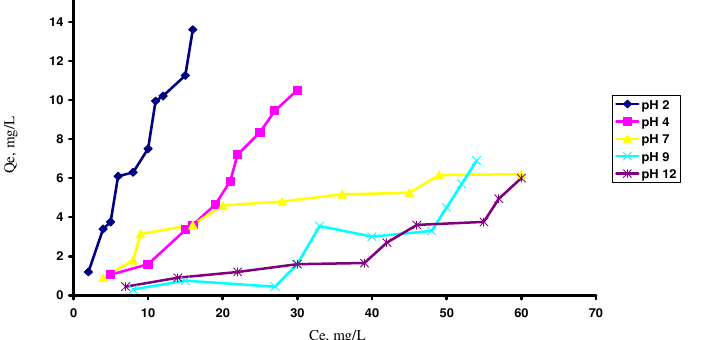
Figure 6. Removal of colour from aqueous solution of sulphanilic azo antipyrine at various